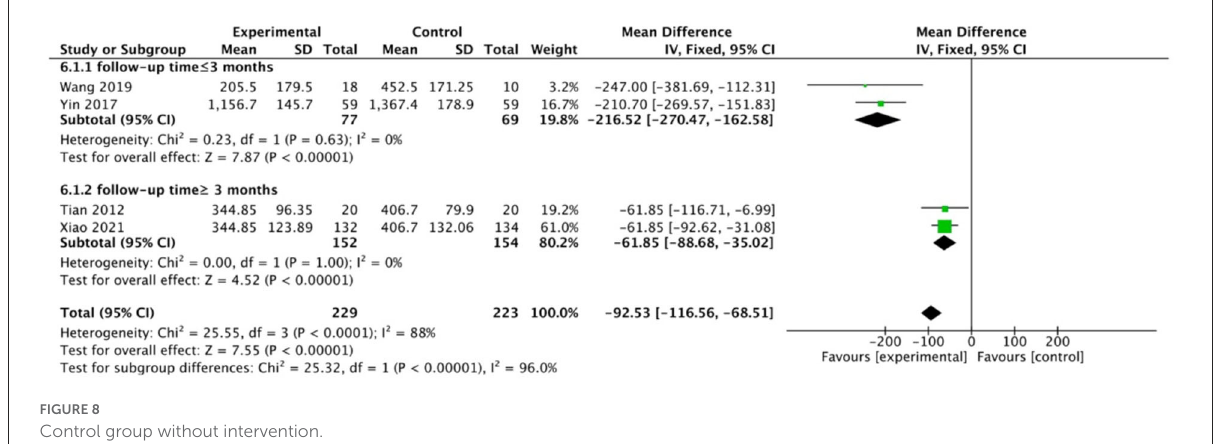
FIGURE8 Control group without